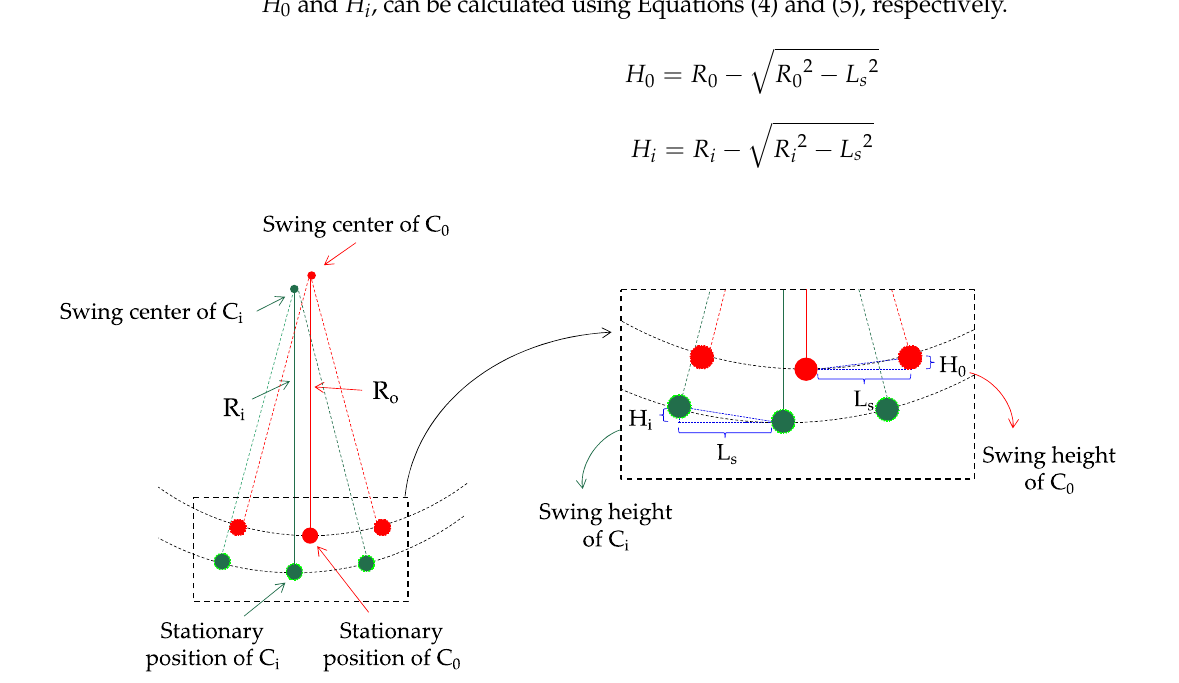
Figure 5. Schematic diagram of transverse swing of cable strand.